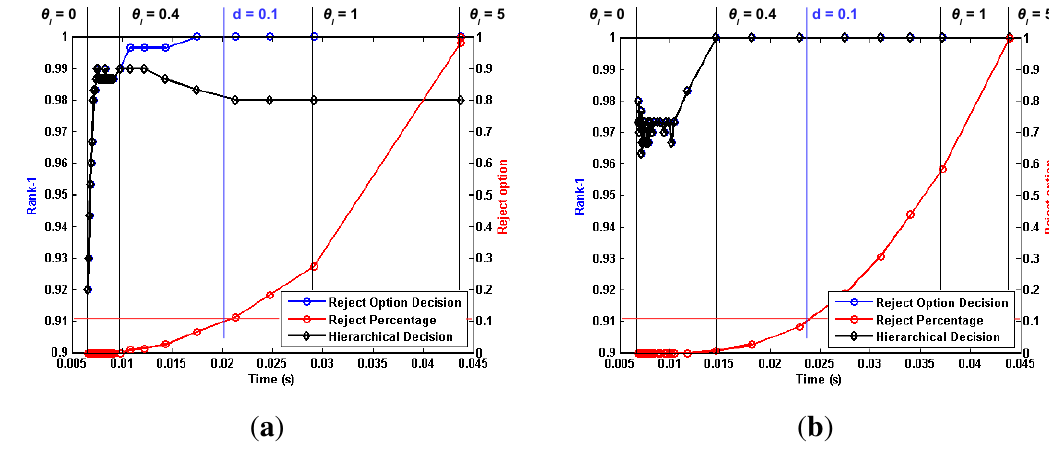
Figure 7. Main results obtained with the proposed methodology for the sunglasses and scarf images of the AR face database. Each plotted point represent a specific value of parameter θ , ranging from [0 , ∞ ] l